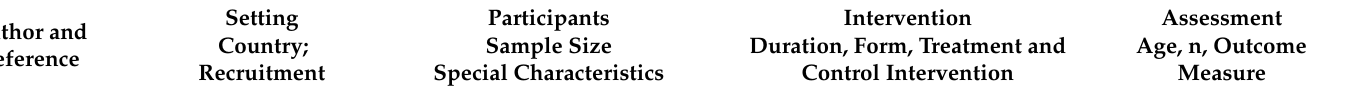
Table 1. Summary of the characteristics and results of randomized controlled trials included in the